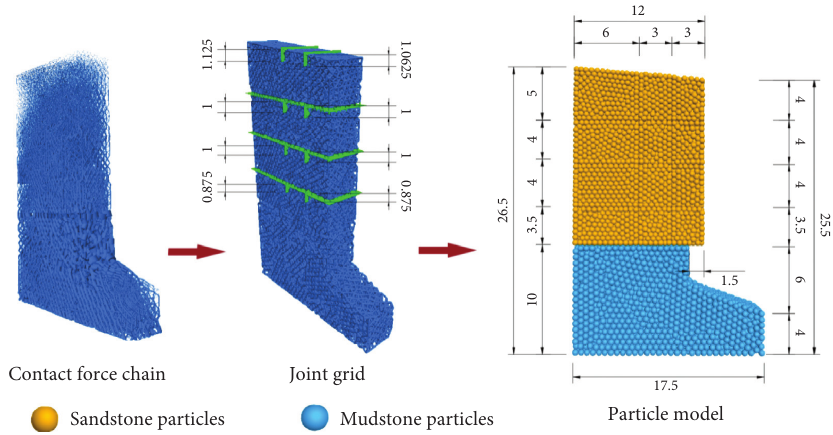
Figure 15: Slope force chain and joint grid layout (unit: